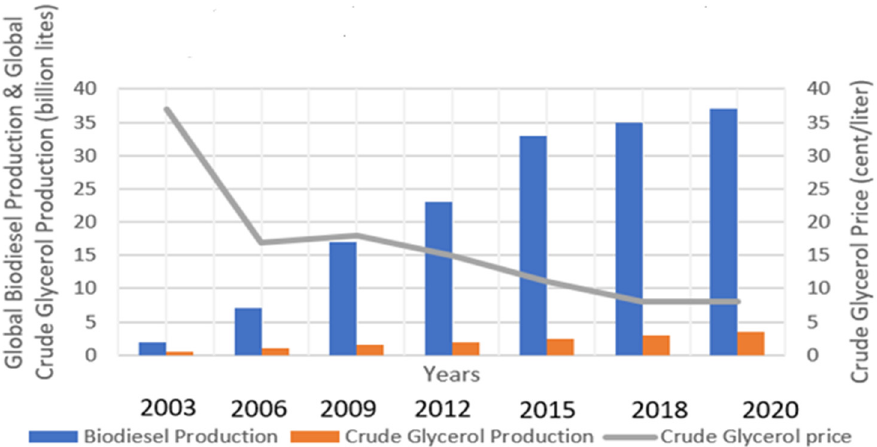
Figure 1. Global biodiesel production of crude glycerol production [30].